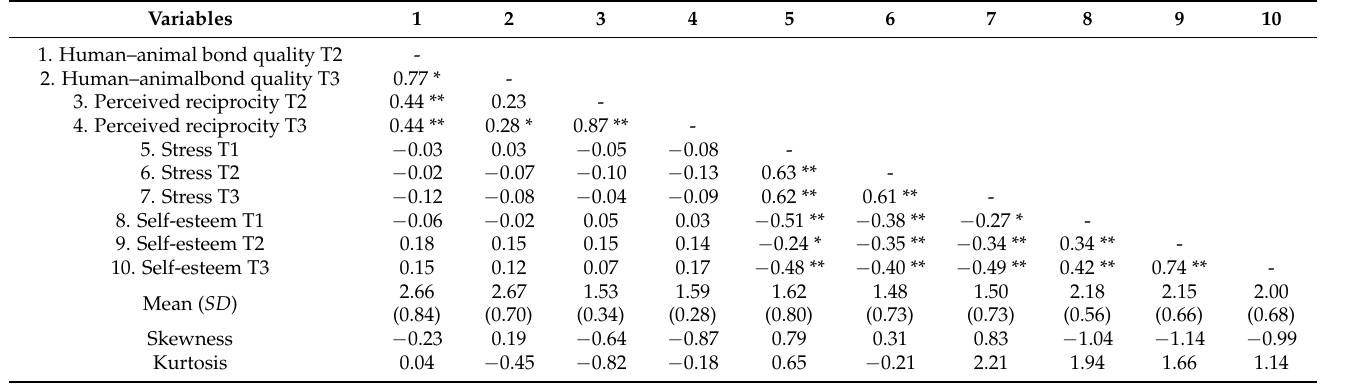
Table 2. Descriptive Statistics and